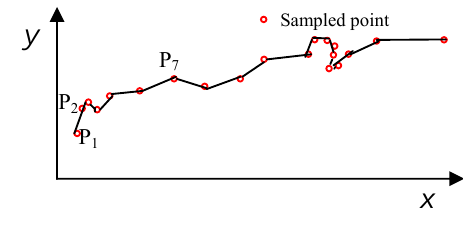
Fig.2. Illumination of a polyline trajectory